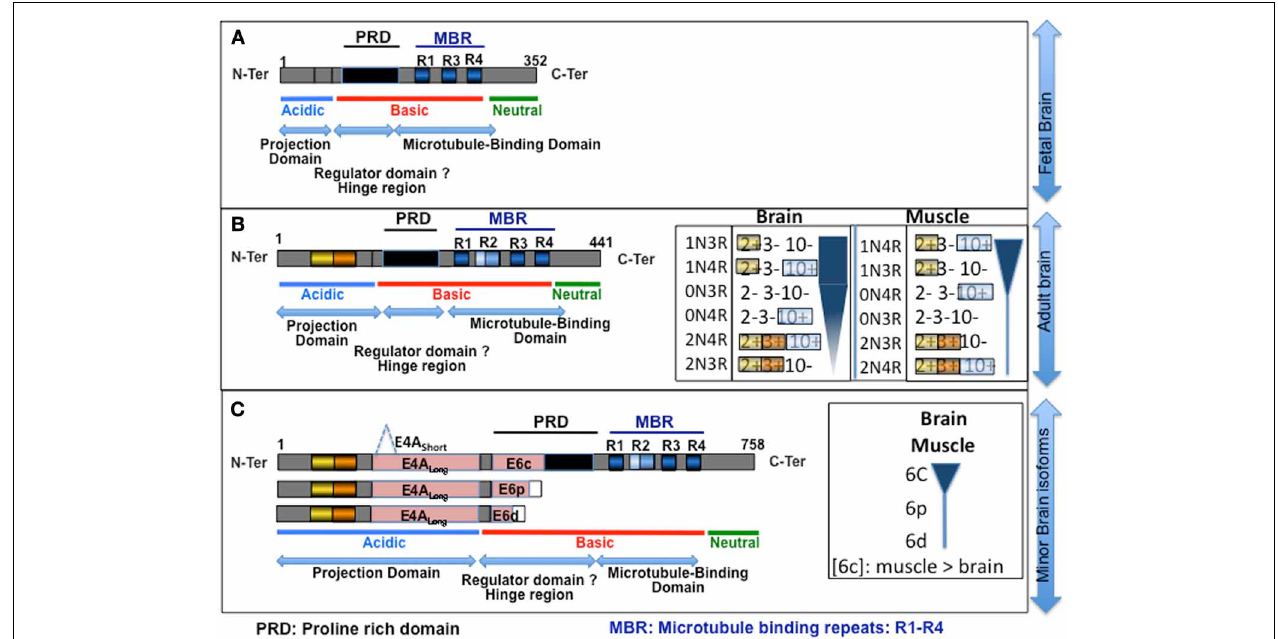
FIGURE 3 | Schematic of the Tau isoforms. (A,B) isoforms primarily expressed in fetal and adult brains, respectively, (C) poorly expressed in brain. The different structural domains are indicated at the bottom of each panel. The inserts in (B) represent the differential expression of Tau isoforms in the adult brain, and the tissue specificity of the splicing is illustrated by comparison with skeletal muscle expression; the width of the diagram corresponds to level of the corresponding isoform [drawn from Mulot et al. (1994), Boutajangout et al. (2004), Andreadis (2005), Trabzuni et al. (2012)]. Exon 4A Short and Long and exons 6c, p, and d correspond to distinct 3 (cid:2) sites